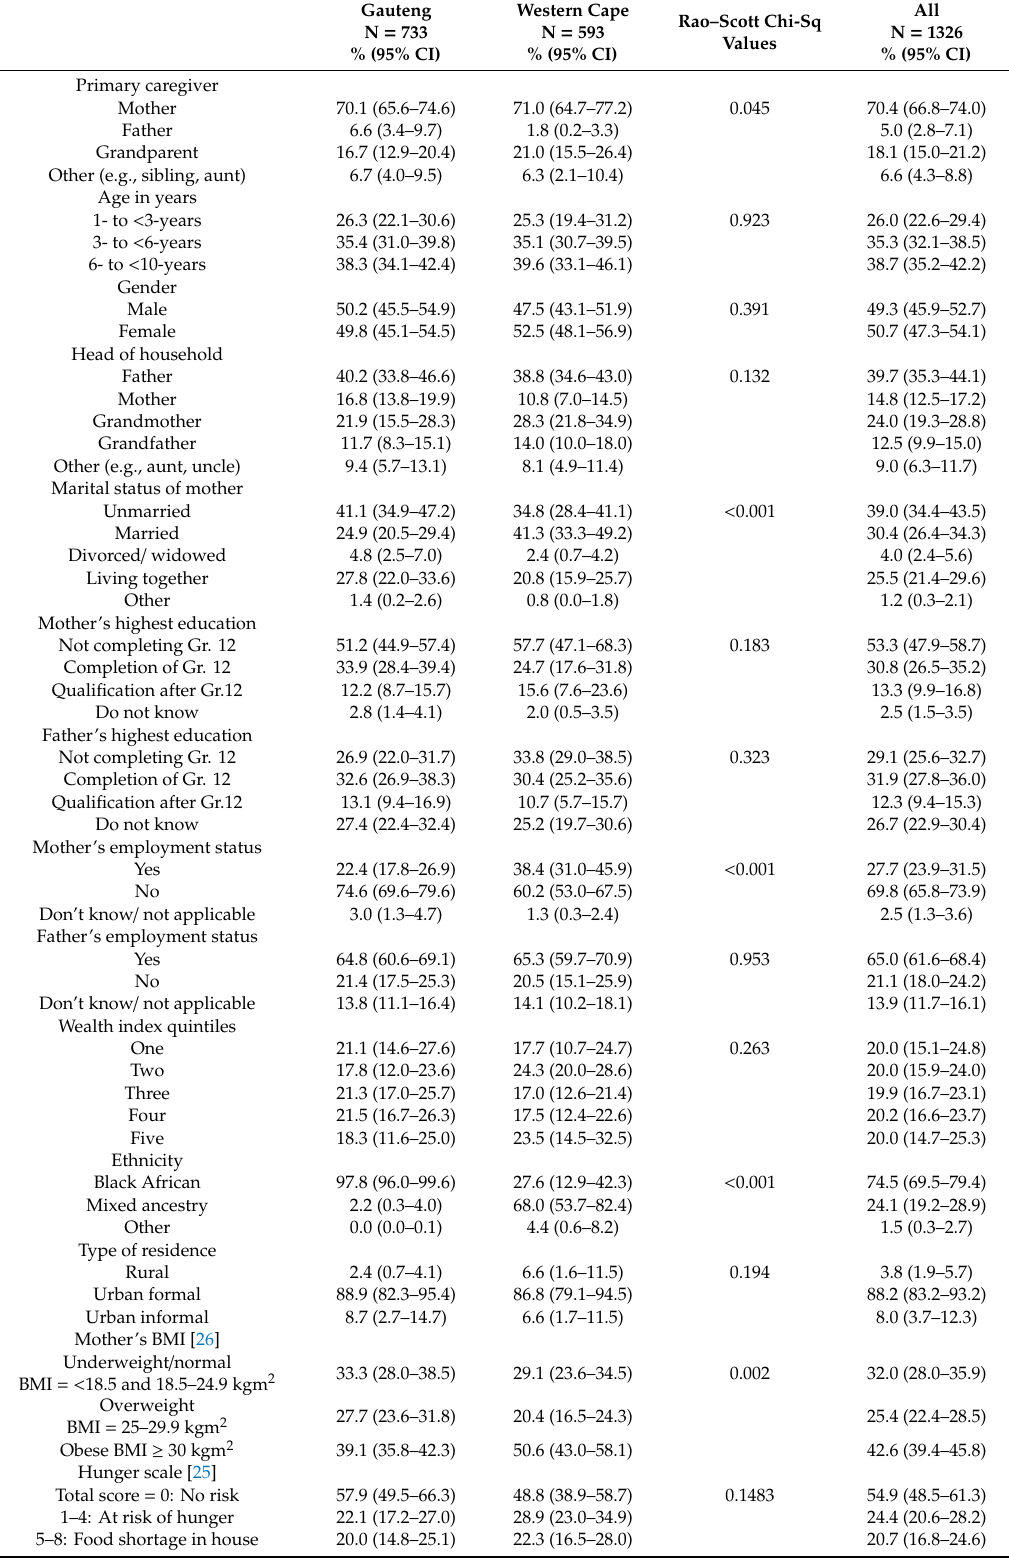
Table 1. Sociodemographic and other characteristics of parents and 1- to < 10-year-old children in the two provinces